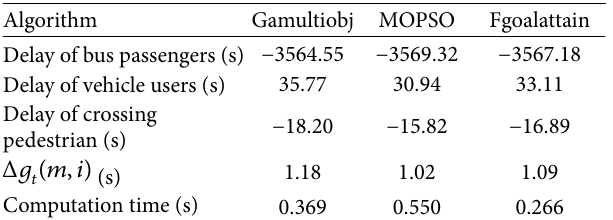
Table 5: Results of delay model in situation 1 during the nonpeak period.